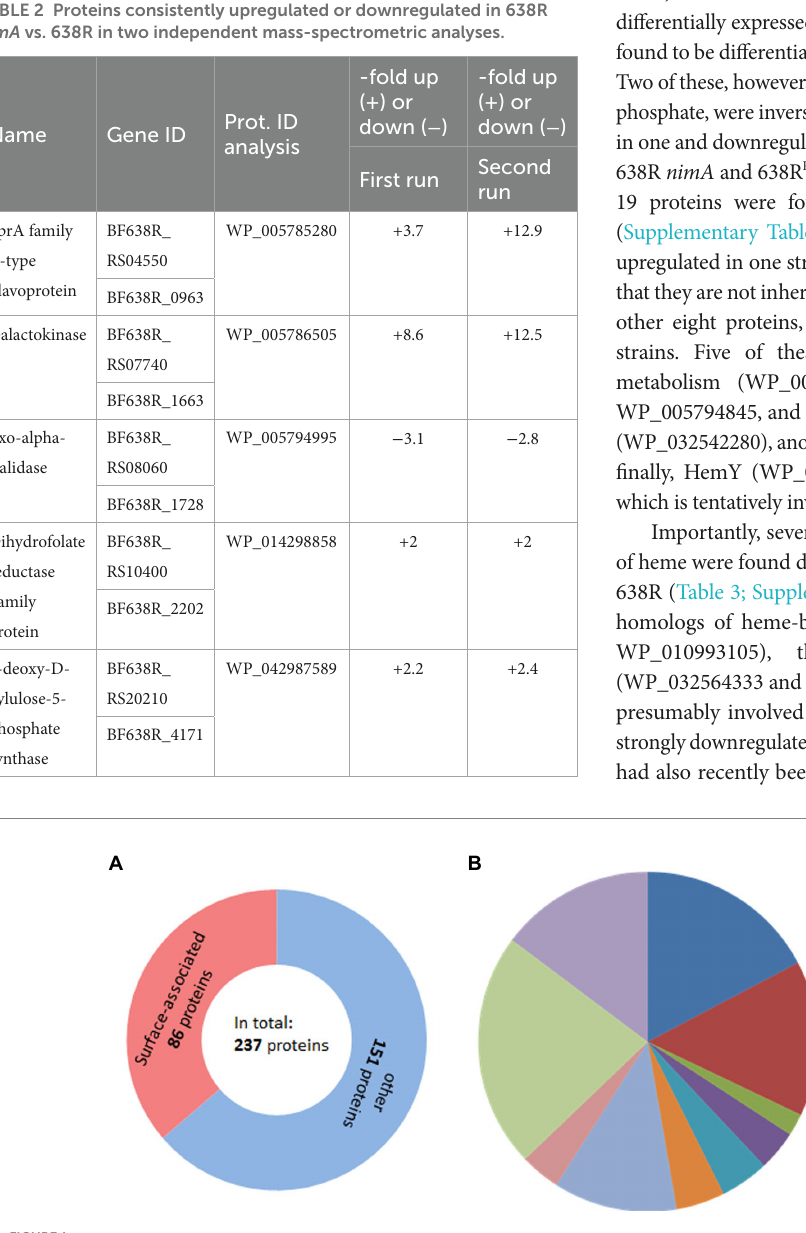
FIGURE 1 Proteins identified to be differentially expressed in Bacteroides fragilis 638R R as compared to 638R. (A) Total number of proteins differentially expressed as compared to wildtype 638R and their cellular localization. (B) Pie chart indicating the functions of the proteins differentially expressed in 638R R